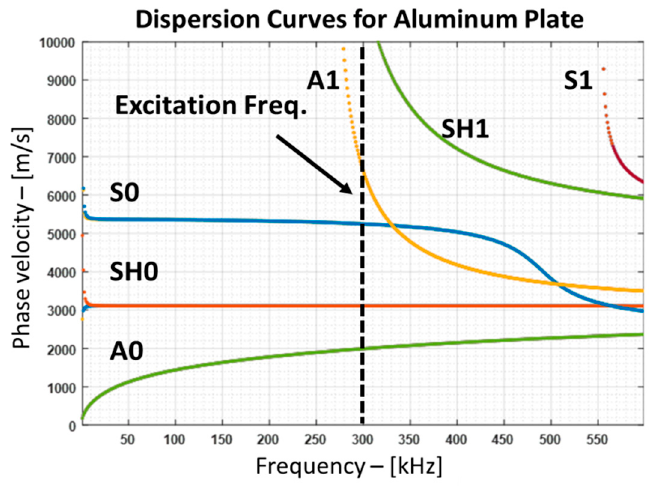
Figure 6. Phase velocity dispersion curves for aluminium 2024 plate with 1.6 mm thickness.